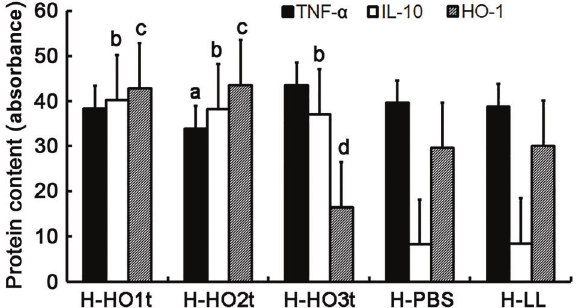
Figure 3. Levels of TNF- a , IL-10 and heme oxygenase-1 (HO-1) in the intestine of hemorrhagic shock (HS) rat groups treated with Lactococcus lactis expressing heme oxygenase-1 once (HO1t), twice (HO2t) or thrice (HO3t) or with phosphate-buffered saline (PBS) and L. lactis (LL). abc P o 0.05: compared with the cor- responding PBS and LL groups (ANOVA). Data are reported as means ± SD.